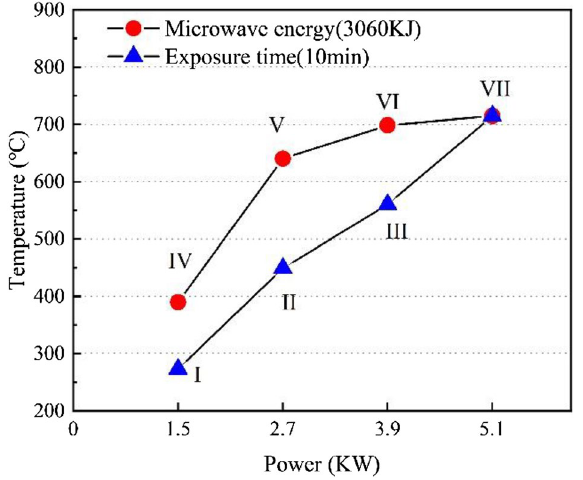
Figure 6. Relationship between the maximum surface temperature with power